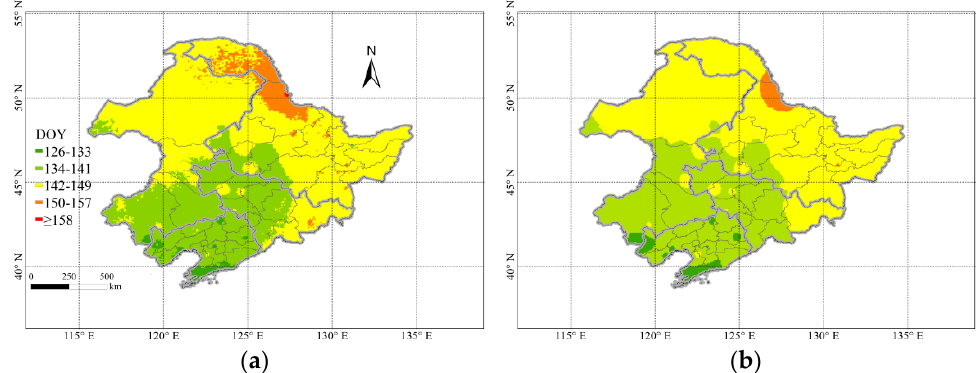
Figure 4. Maize emergence stage (VE) in Northeast China (( a ) fusion data; ( b ) original data).